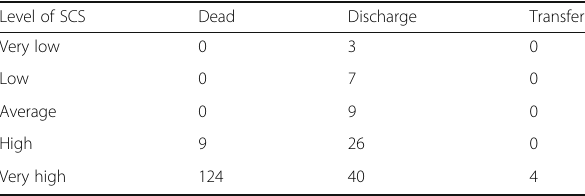
Table 1 (abstract P23). The level of SCS for all patients Level of SCS